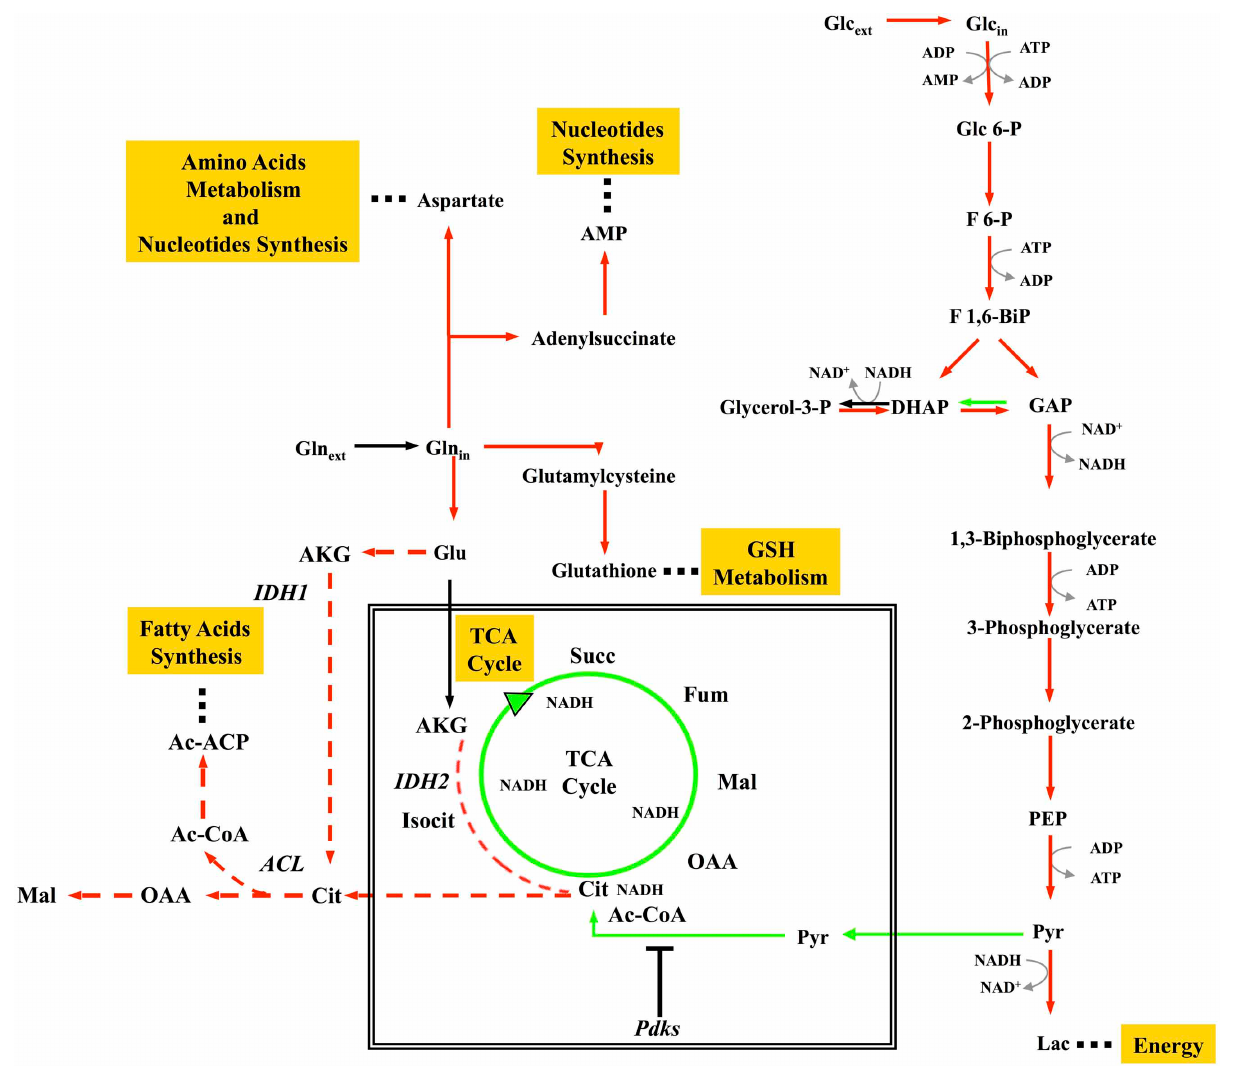
biosynthesis of proteins, nucleotides, and lipids. Red arrows represent enhanced flux, green arrows represent reduced flux, black arrows represent unchanged flux, red dotted arrows represent enhanced reductive carboxylation